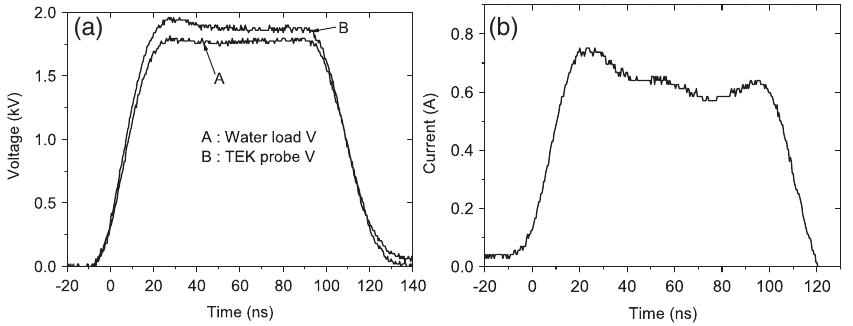
FIG. 12. Results of water load calibration: (a) voltages; (b)